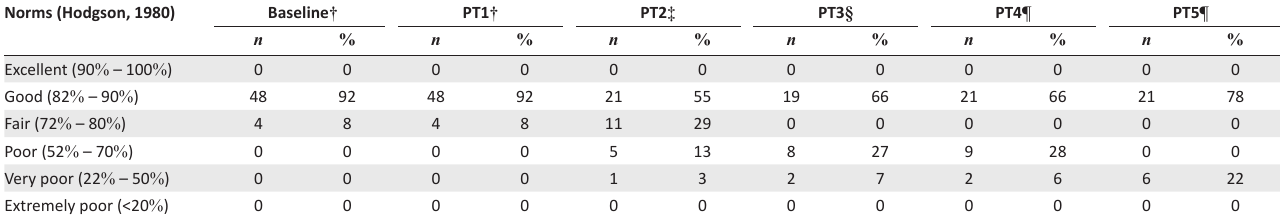
FIGURE 9: Type of hearing loss over treatment duration (left ear). TABLE 4: Speech discrimination results: Speech discrimination (Better ear). Norms (Hodgson, 1980)